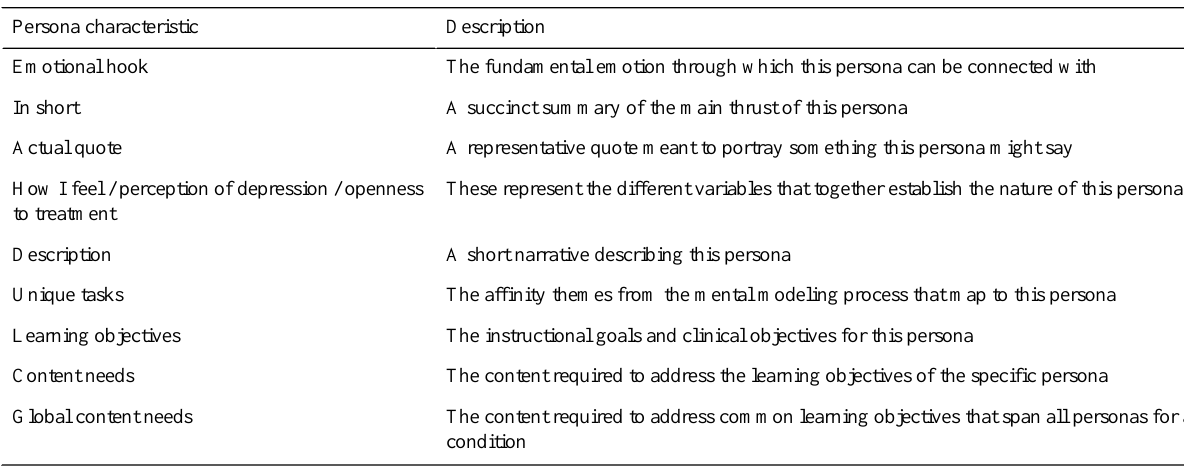
Table 1. Elements of all chronic disease